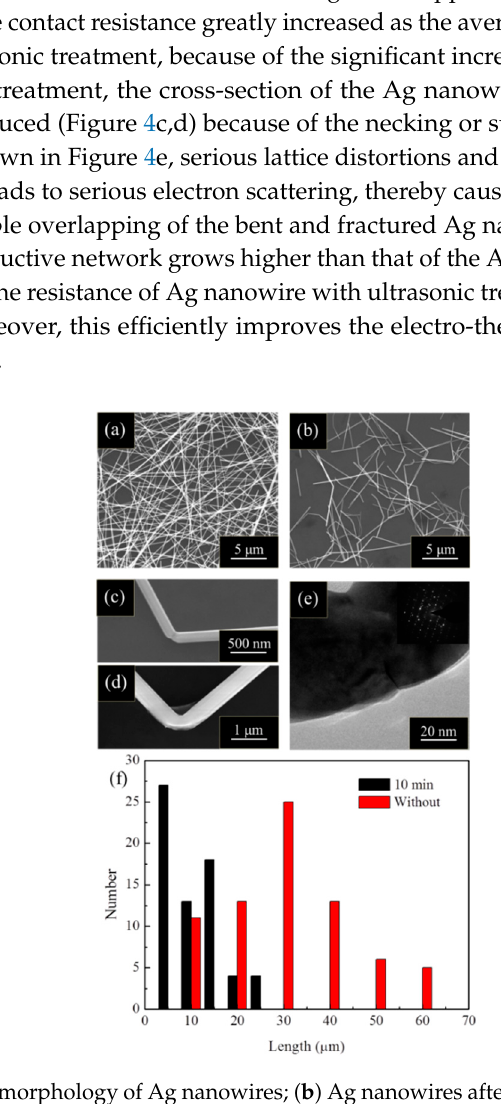
Figure 4. ( a ) Original morphology of Ag nanowires; ( b ) Ag nanowires after 10 min ultrasonic treatment; ( c , d ) bending deformation of Ag nanowire with different diameters; ( e ) TEM and selected area electron diffraction (SAED) on the bent area of Ag nanowire; ( f ) statistical results of the length of Ag nanowires before and after 10 min ultrasonic treatment.